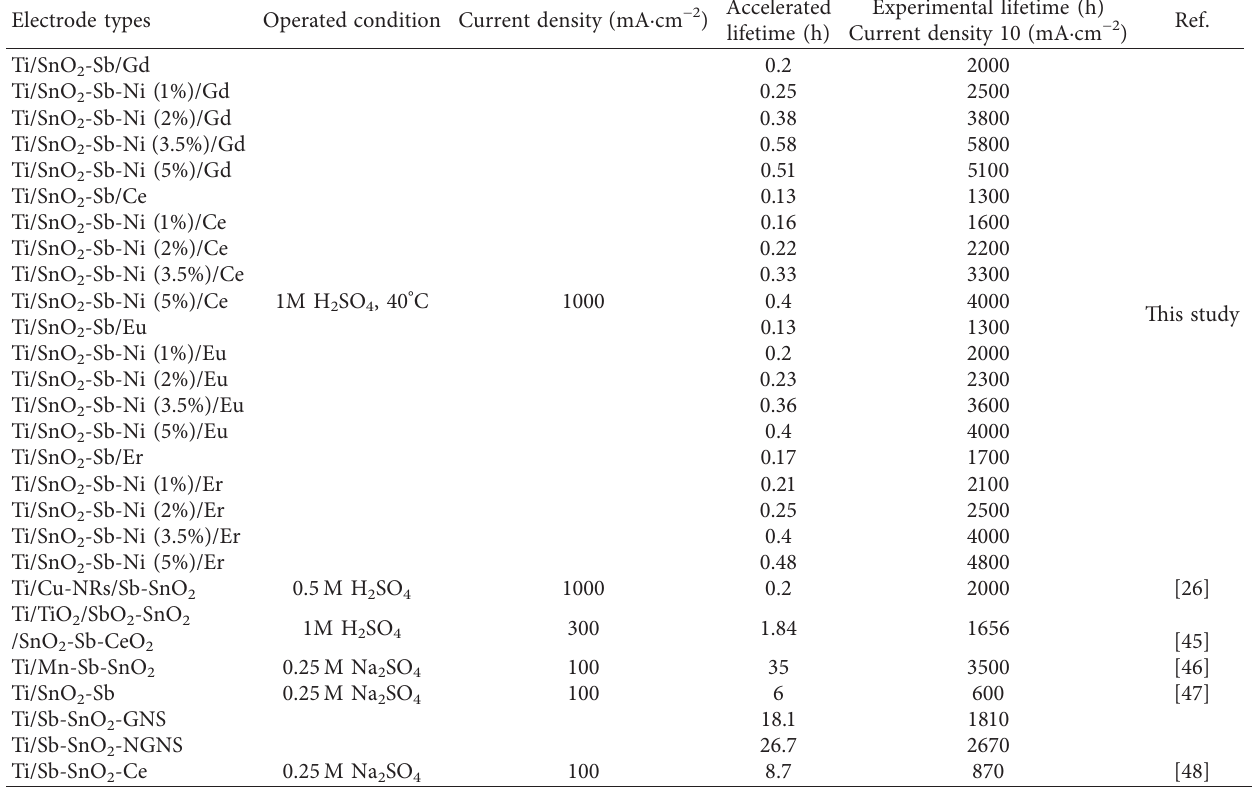
2 -Sb electrodes in some previous works and this work.